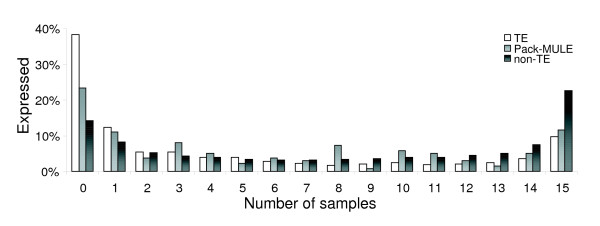
Summary of expression of Pack-MULEs in comparison with other TE-related and non-TE-related gene models. Levels of transcription can be inferred based on how often expression was detected in the different samples for each group. TE, transposable element.